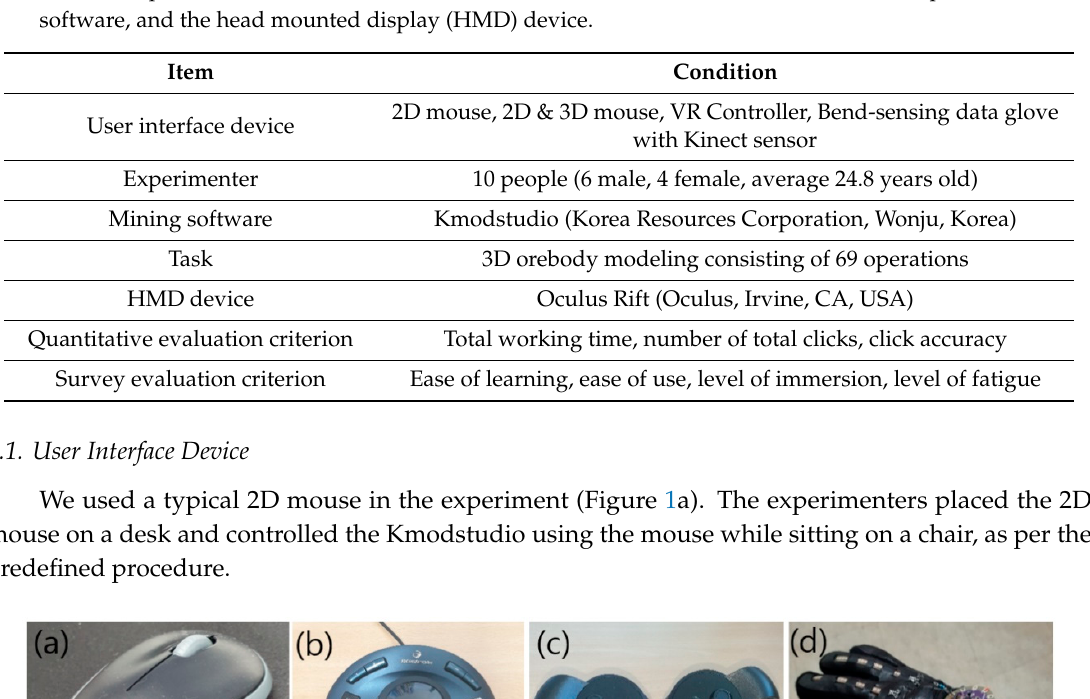
Table 1. Experimental conditions and evaluation criteria related to user interface devices, experimenter, software, and the head mounted display (HMD) device.